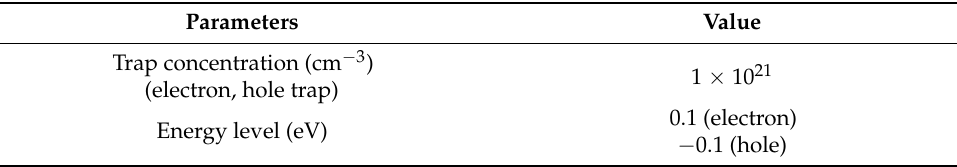
Table 1. Trap parameters of polysilicon channel.